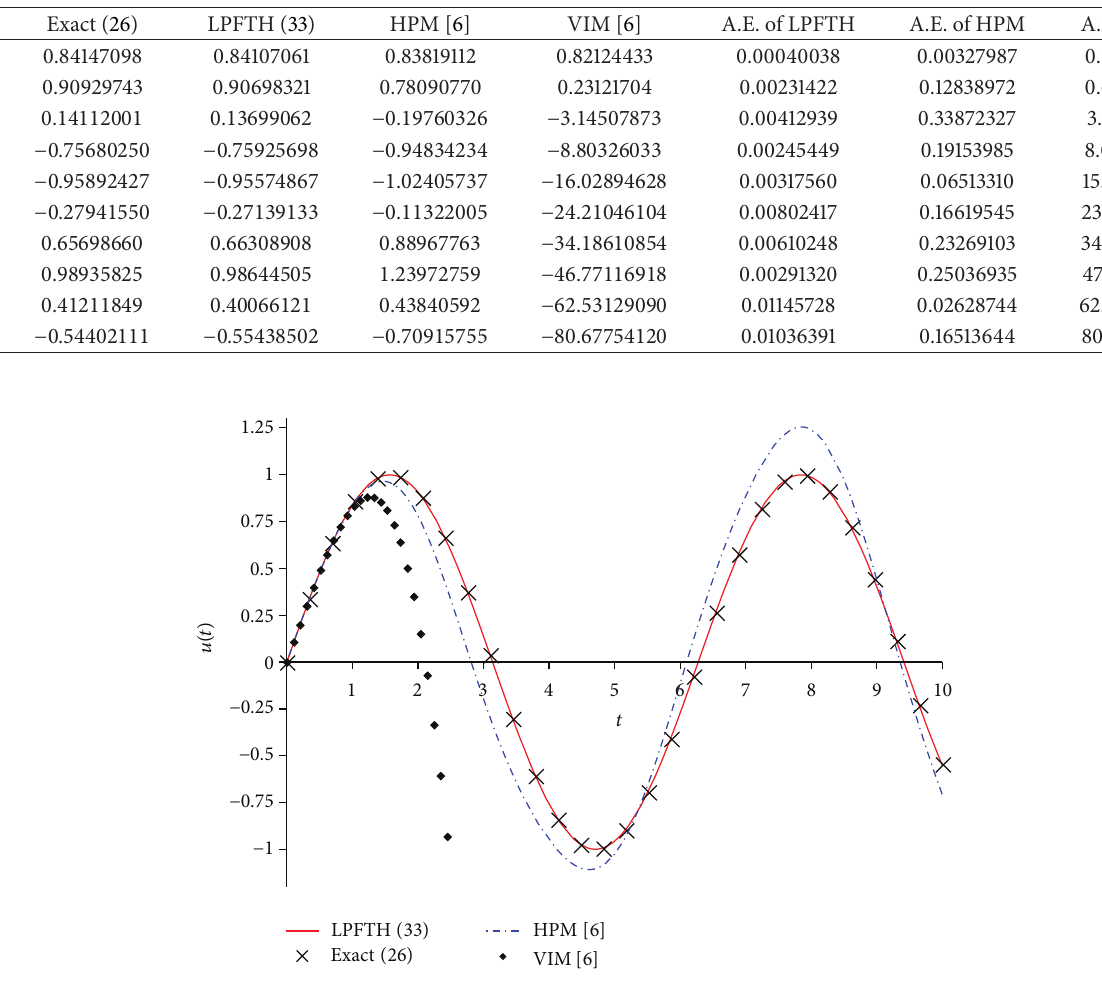
Figure 1: Exact solution (26) (diagonal cross) for (25) and its approximate solutions (33) (solid line), HPM [6] (dash-dot), and VIM [6] (solid